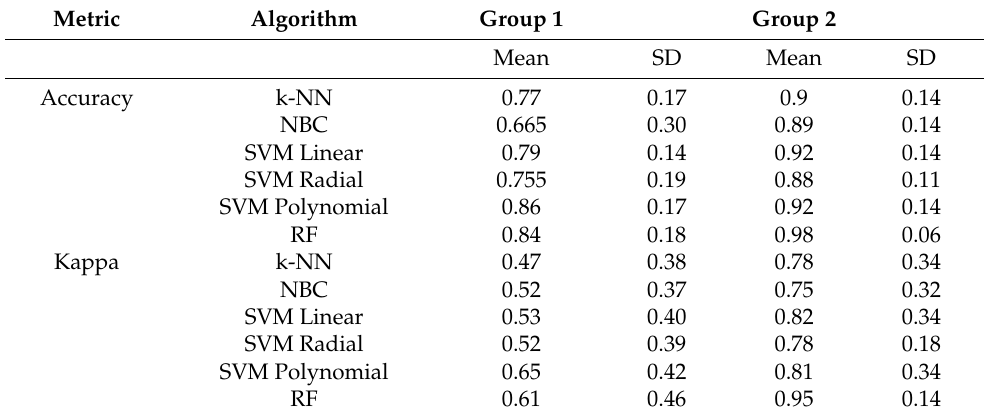
Table 1. Comparative of machine learning algorithms. We used the metrics accuracy and Kappa, for comparing different algorithms in group 1 or constitutive scent profile (pFreqCutoff = 1.0) and group 2 (pFreqCutoff = 0.7). k-NN: k-Nearest Neighbors, NBC: Naïve Bayes Classifier, SVM: Support Vector Machine, RF: Random Forest, SD: standard deviation. Metric Algorithm Group 1 Group